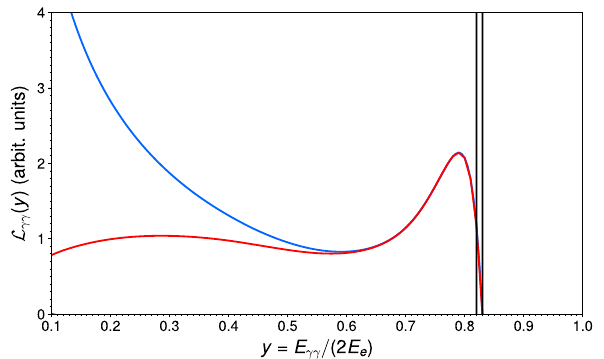
Fig. 3 Photon energy distribution f ( x ) for the luminosity spectra L γγ ( y ) from Fig.